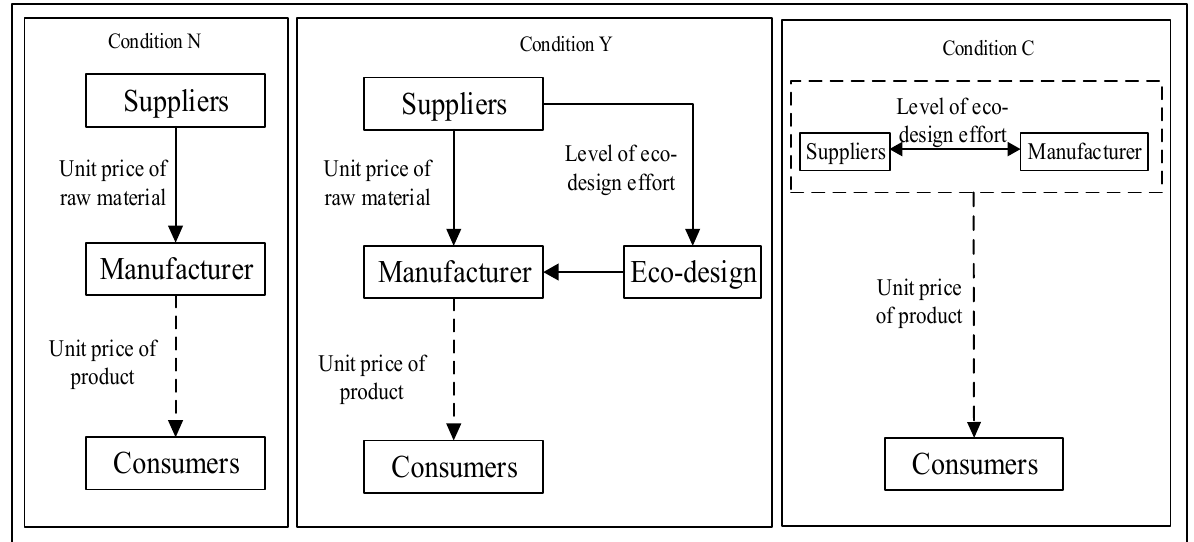
Figure 2. Schematic diagram of the decision-making game theory model between suppliers and manufacturers.